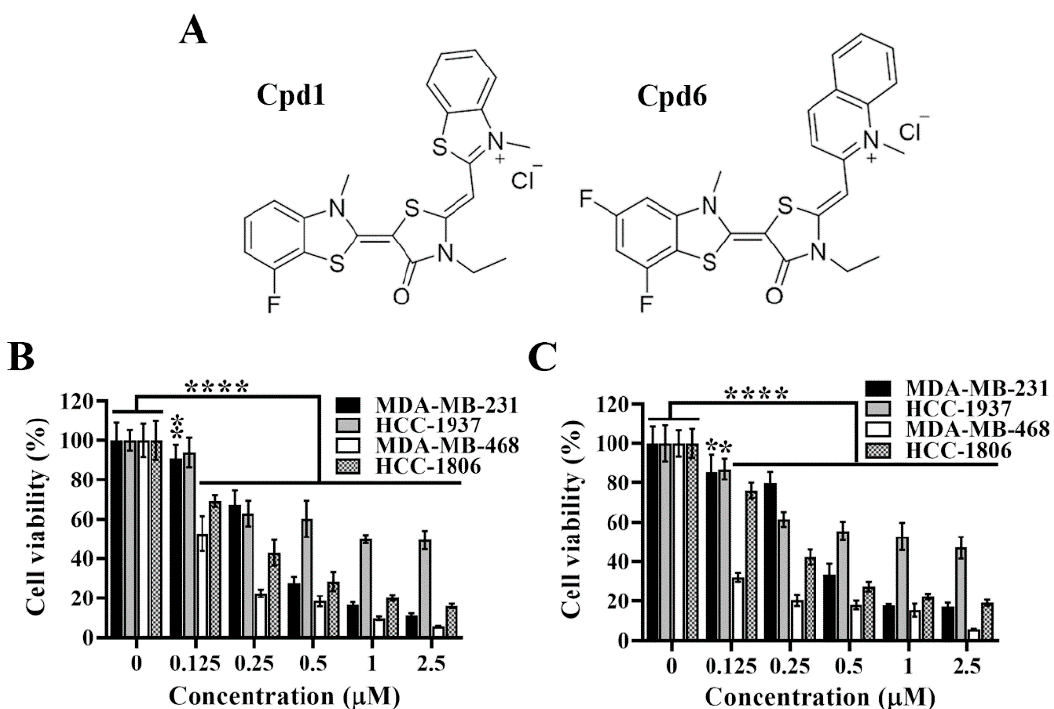
Figure 2. Evidence that compound 1 and compound 6 exhibit high potency in suppressing triple negative breast cancer cells viability. ( A ) Chemical structures of compound 1 and compound 6. ( B ) Dose-dependent suppressive effects of compound 1 and ( C ) compound 6 on the viability of MDA- MB-231, HCC-1937, MDA-MB-468 and HCC-1806 cells after 72 h treatment. Cell viability was de- termined by MTT assays. Columns, means; bars, S.D., * p < 0.05, ** p < 0.01, **** p < 0.0001.